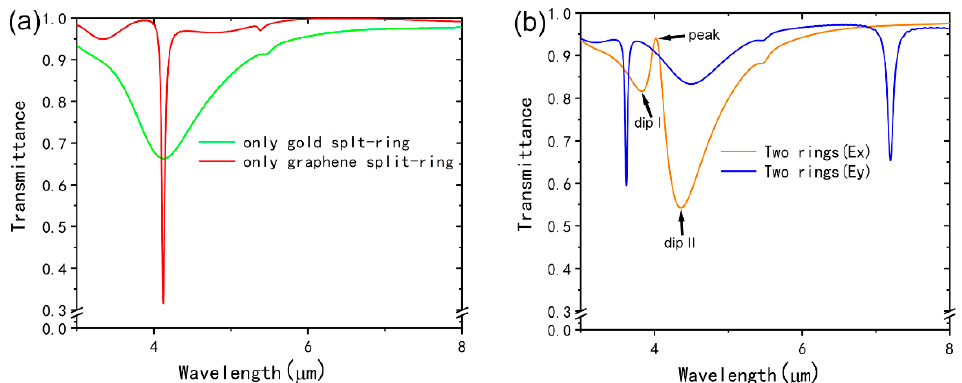
Figure 2. ( a ) Transmission spectra of the individual graphene split-ring and the individual gold split-ring. ( b ) Transmission spectra of the structure consists of graphene split-ring and gold split-ring under x-polarized and y-polarized incident light excitation, respectively.